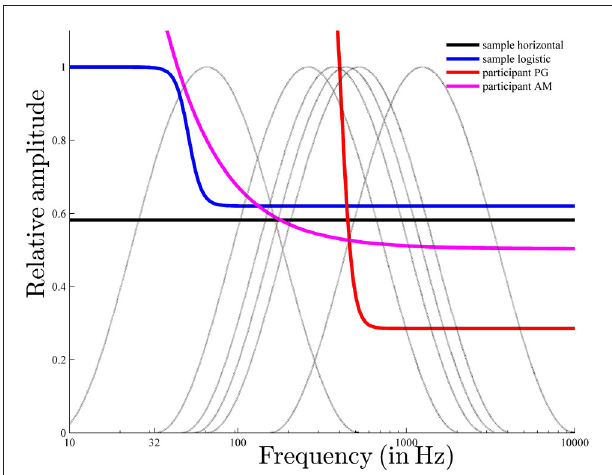
FIGURE 12 | The six envelopes used in the experiment (gray lines) along with the estimated horizontal and logistic sample threshold functions and the individual logistic threshold functions for participants PG and AM, with pronounced pitch class and envelope effects, respectively. The estimated parameters of the horizontal sample threshold function were σ 2 0.19; that of the logistic sample were ˆ = l σ 2 0, 0.18; that of the logistic for “PG” were = ˆ == q σ 2 0.29, ˆ l 0.57, 0.27; and that of the logistic for “AM” ˆ = = − ˆ =